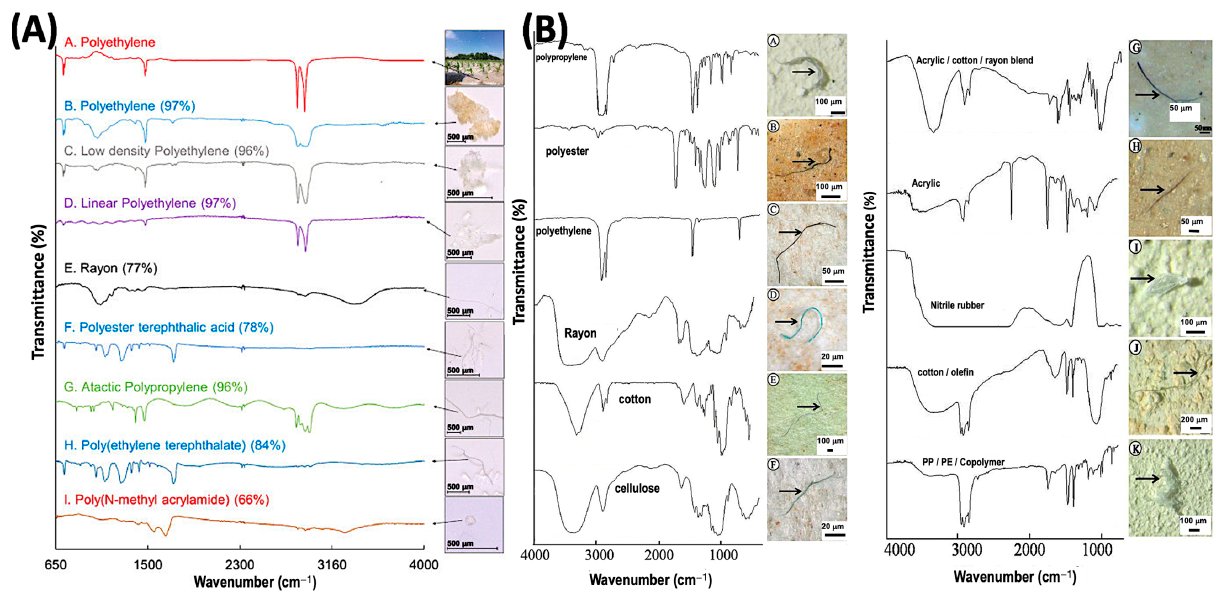
Figure 5. ( A , B )—FTIR spectra and optical images of MPs of various compositions. Characteristic peaks differ based upon MP composition. Figures have been reproduced from Refs. [40,58] with permission of publishers.